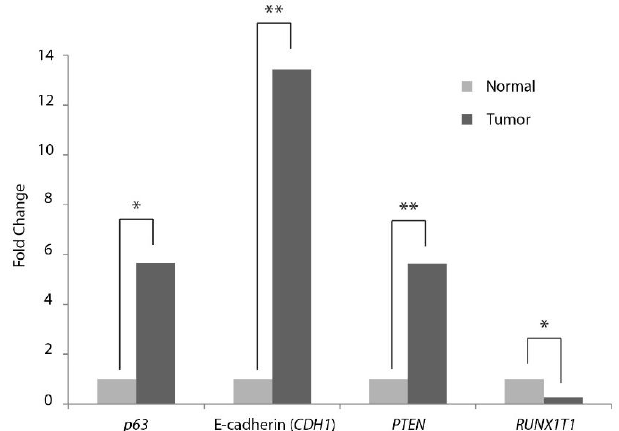
Figure 2. RT-qPCR re-evaluation of differentially expressed mRNA in meningioma. Fold changes of analyzed mRNA expression relative of 15 tumors, compared to four normal dura (3N +1NN) (see Table 1 and Table S5a). Three reference genes were used ( GAPDH , ACTB ( β -Actin) and HPRT ). One asterisk (*) indicate p -value < 0.05 and two asterisk (**) indicate p -value < 0.001. Table 4. RT-qPCR analysis of mRNA expression, average tumor vs. average normal dura. mRNAs with significant p -values (<0.05) are in bold. Three reference genes were used ( GAPDH , ACTB ( β -Actin) and HPRT